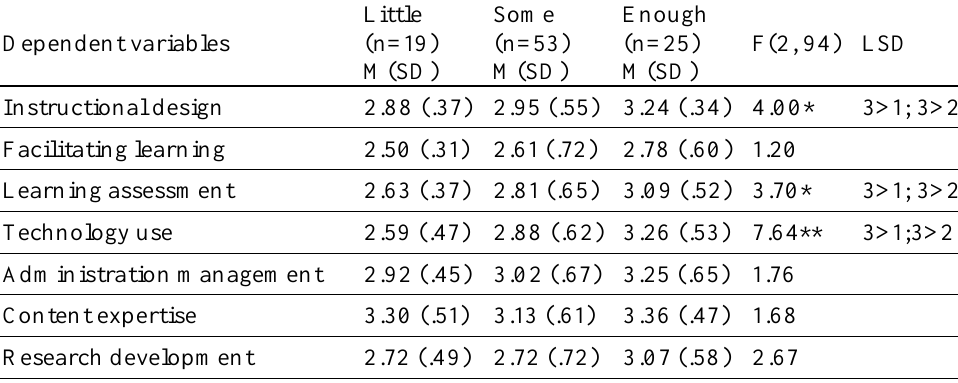
Practices toward Online Instruction among Different Training Support